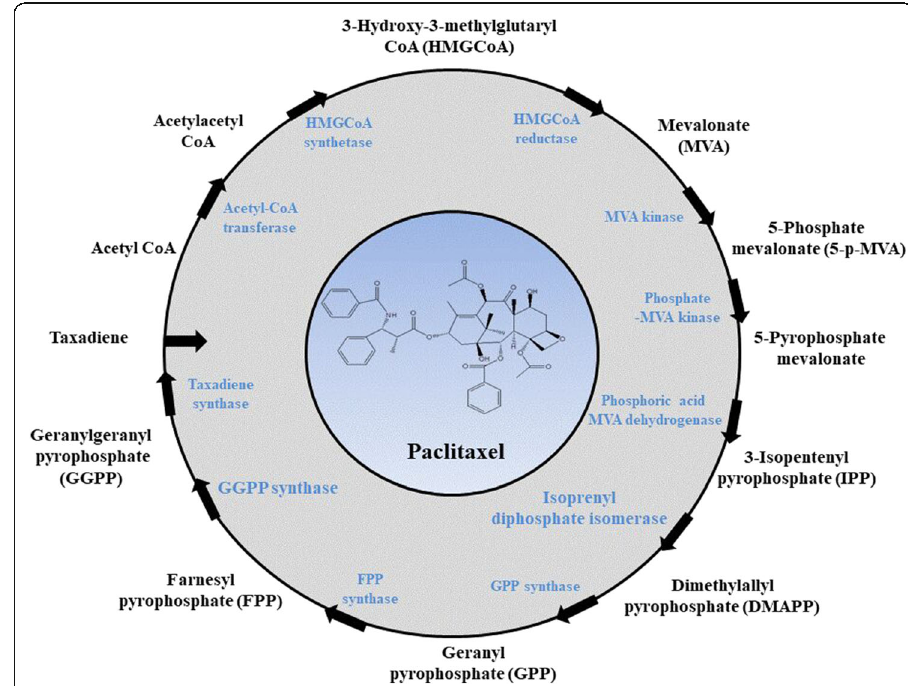
Fig. 2 The biosynthetic pathway of